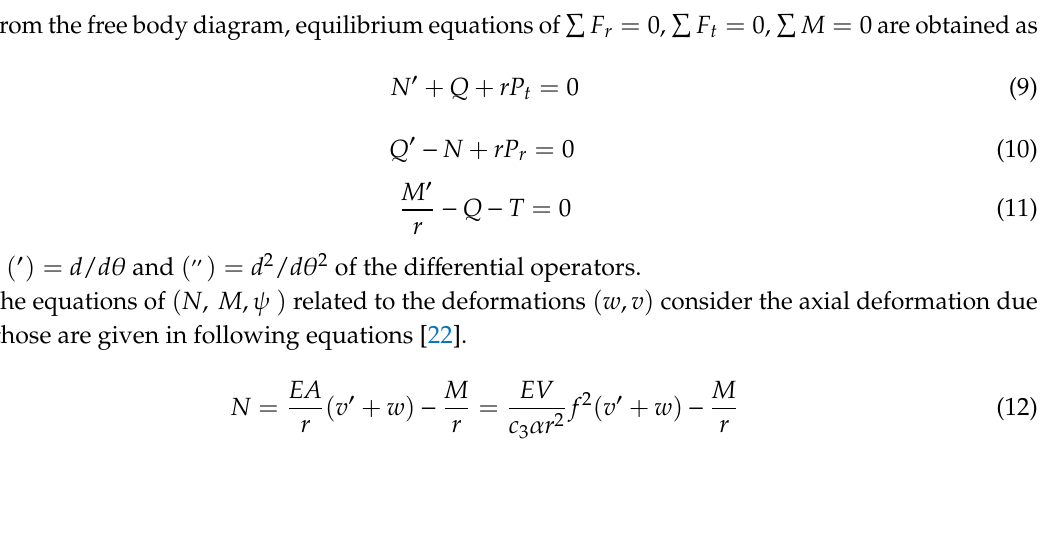
Figure 4. Free body diagram of small arch element.